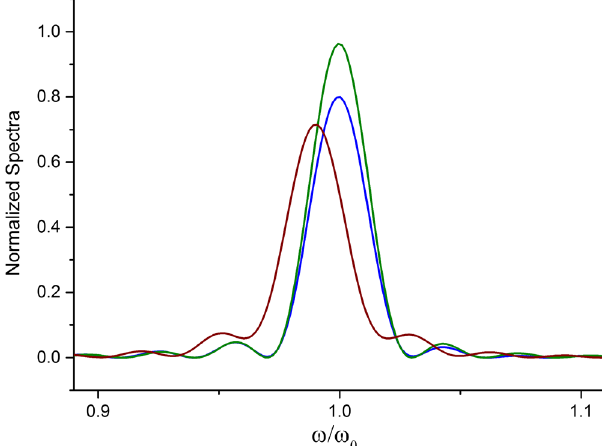
FIG. 10. Spectra of spontaneous emission. Green: ideal un- dulator; blue: random block shift with amplitude of 0.15 cm; red: systematic block shift with the increment of 10 μ m per